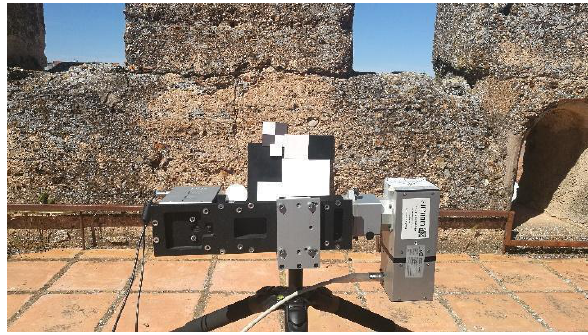
Figure 4. Black and white references used in the test To carry out this study we have been used five white and three black